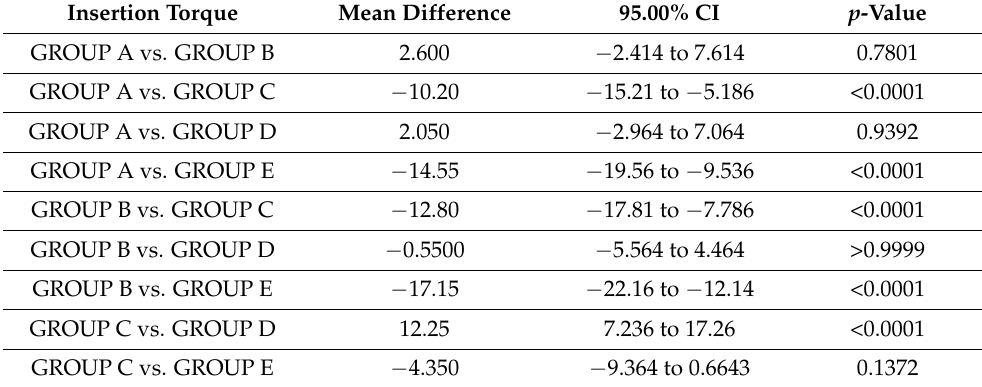
Table 2. Insertion torque comparison between the study groups (ANOVA, Sidak post hoc test).